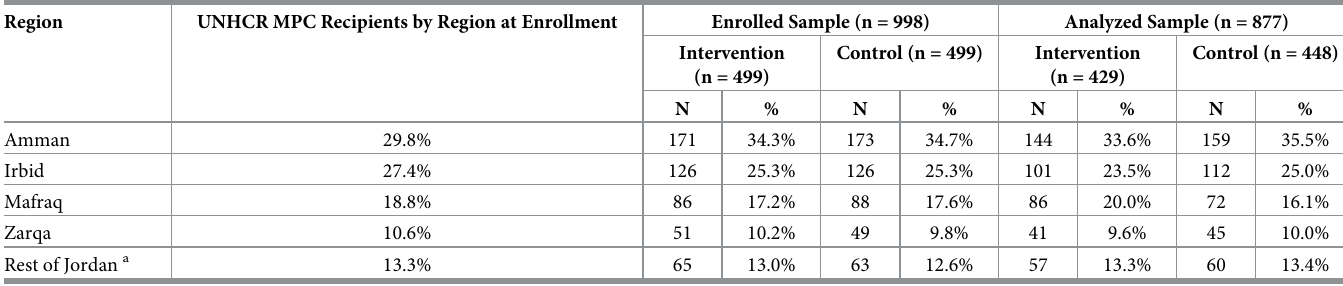
Table 1. Enrolled sample and analyzed sample by region.